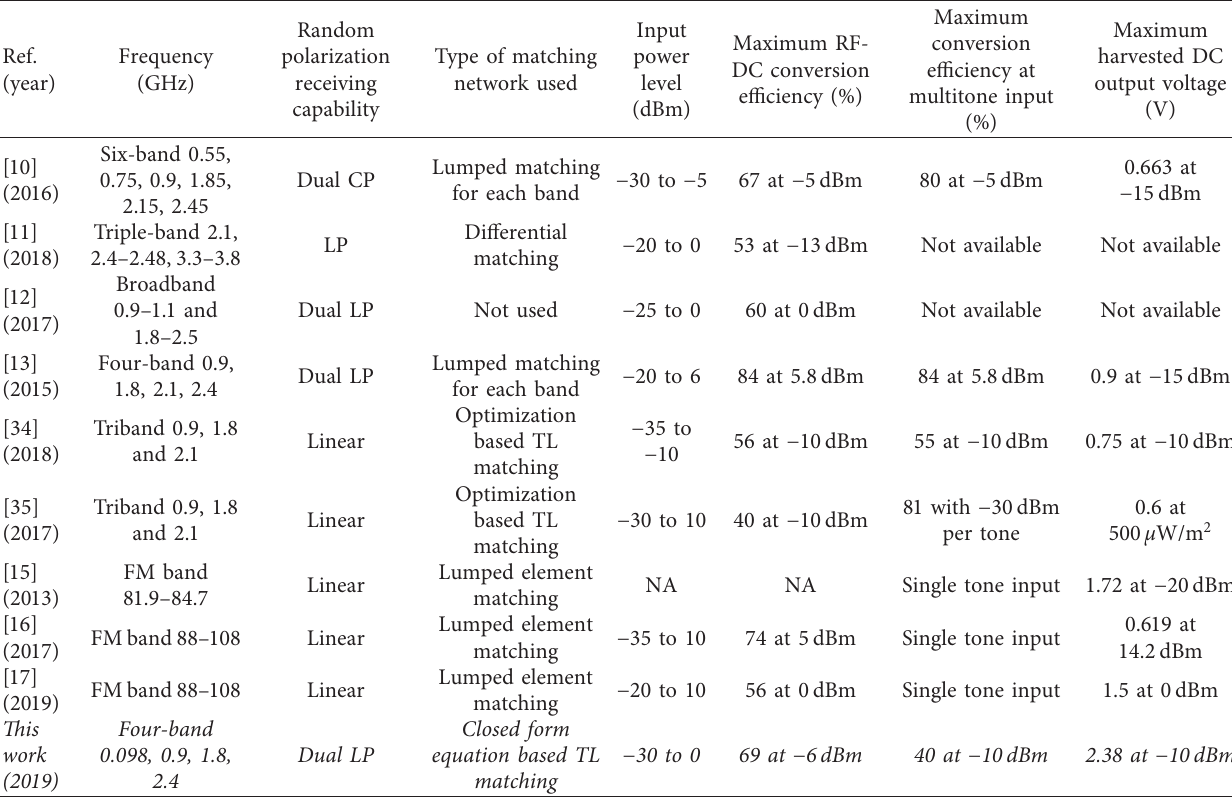
Table 4: Comparison of the proposed rectenna with related designs.